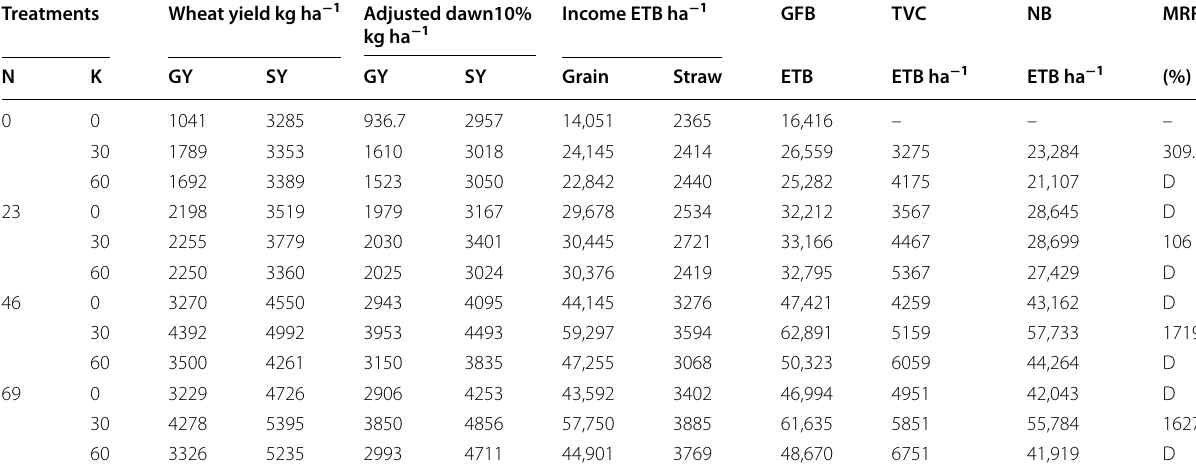
Table 9 Profitability as affected by N and K fertilizer rates